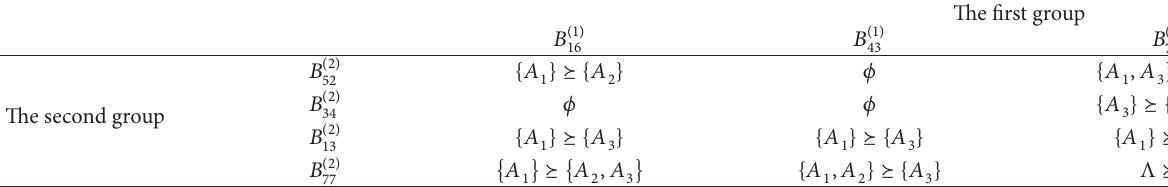
Table 5: The preference intersections for modified Dempster-Shafer combination